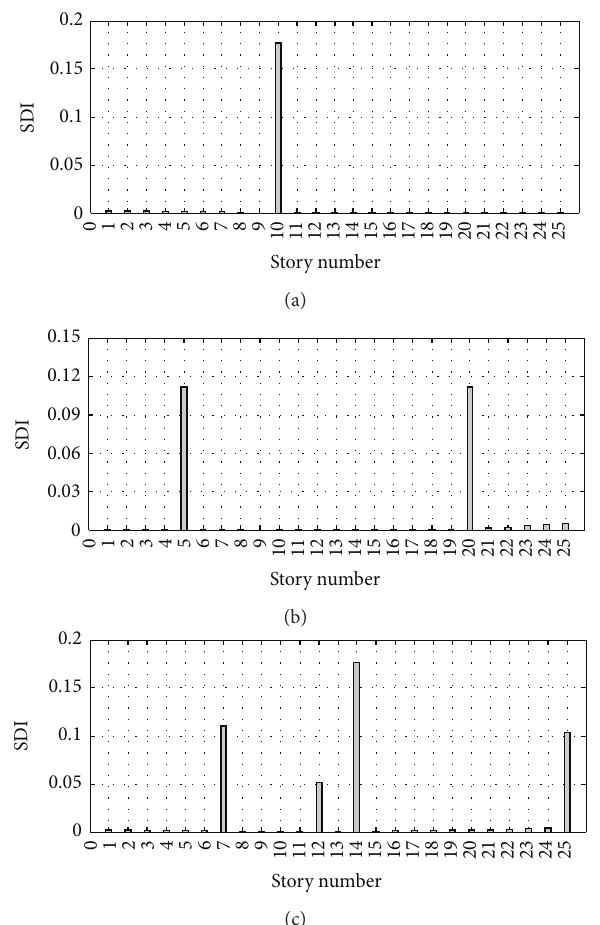
Figure 13: (a) Value of SDI in the 25-story shear frame considering 5 modes for scenario I, (b) value of SDI in the 25-story shear frame considering 5 modes for scenario II, and (c) value of SDI in the 25- story shear frame considering 5 modes for scenario III.